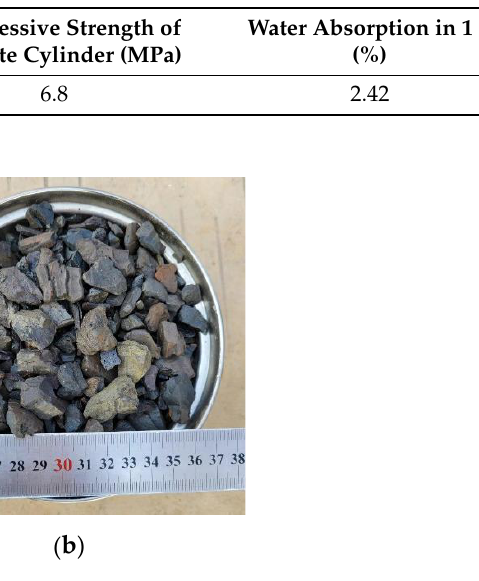
Figure 1. Shale ceramsite. ( a ) Before wetting process. ( b ) After wetting process. Table 2. Physical properties of sand.